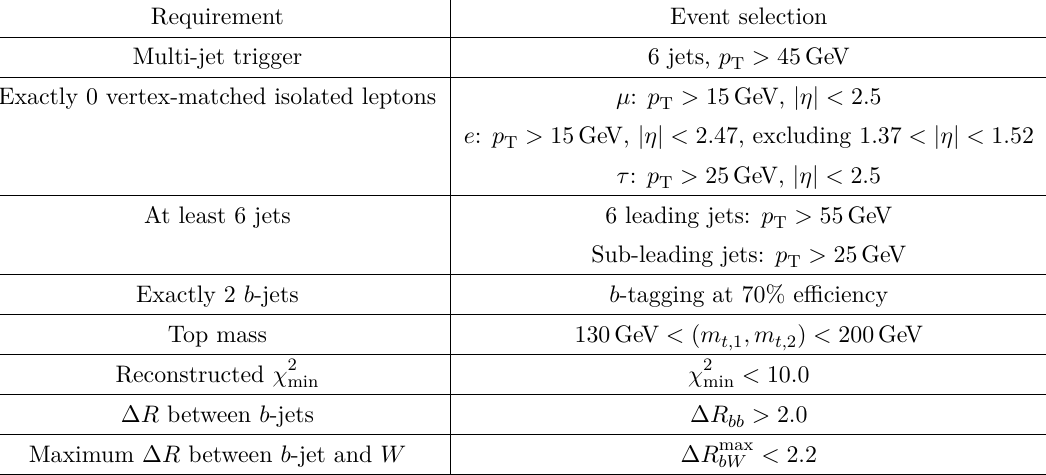
Table 2 . Summary of selection requirements.